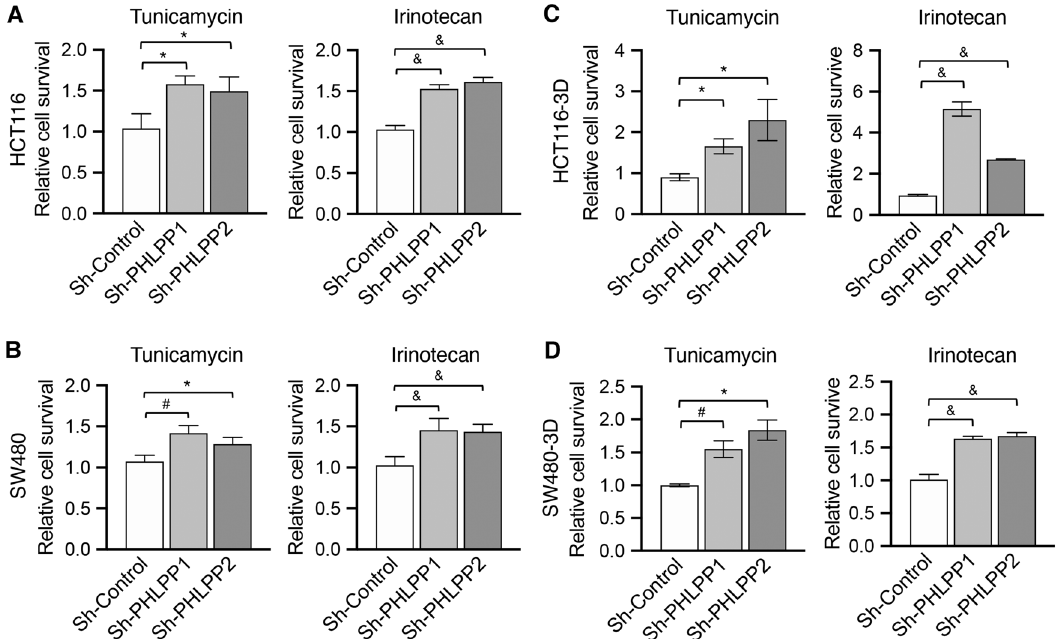
Fig. 6 Downregulation of PHLPP promotes colon cancer cell survival. a – b Control (sh-Control) and PHLPP knockdown (sh-PHLPP1 and sh- PHLPP2) HCT116 (a) and SW480 (b) cells grown in 2D culture were treated with tunicamycin or irinotecan for 48 h. c – d Control (sh-Control) and PHLPP knockdown (sh-PHLPP1 and sh-PHLPP2) HCT116 ( c ) and SW480 cells ( d ) grown in 3D Matrigel were treated with tunicamycin or irinotecan for 48 h. The relative cell survival in PHLPP knockdown cells was normalized to sh-Control cells. Data shown in all bar graphs represent the mean ± SD ( n = 3, & p < 0.001, # p < 0.01 and * p <